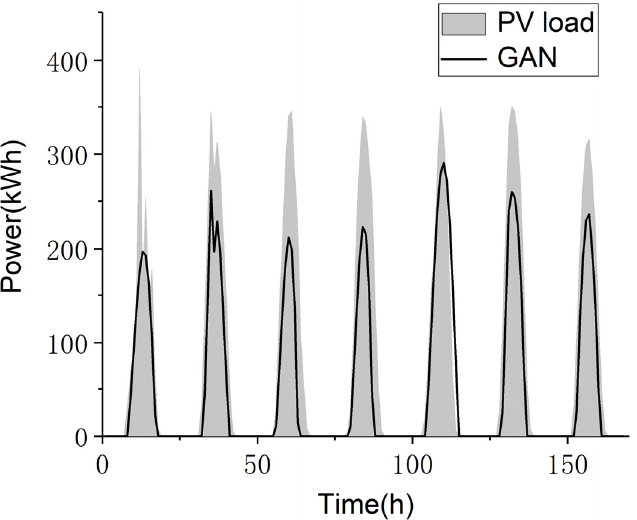
Figure 9. GAN-based prediction PV generation power curve and actual generation power curve.